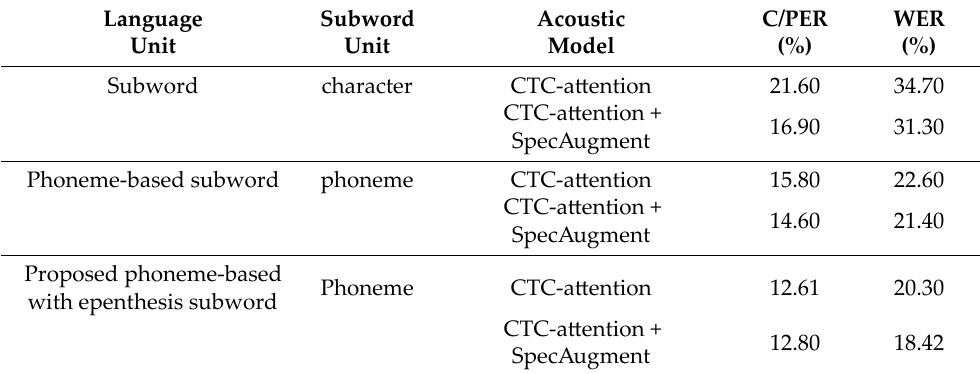
Table 5. Character‑based and phoneme‑based subword decoding